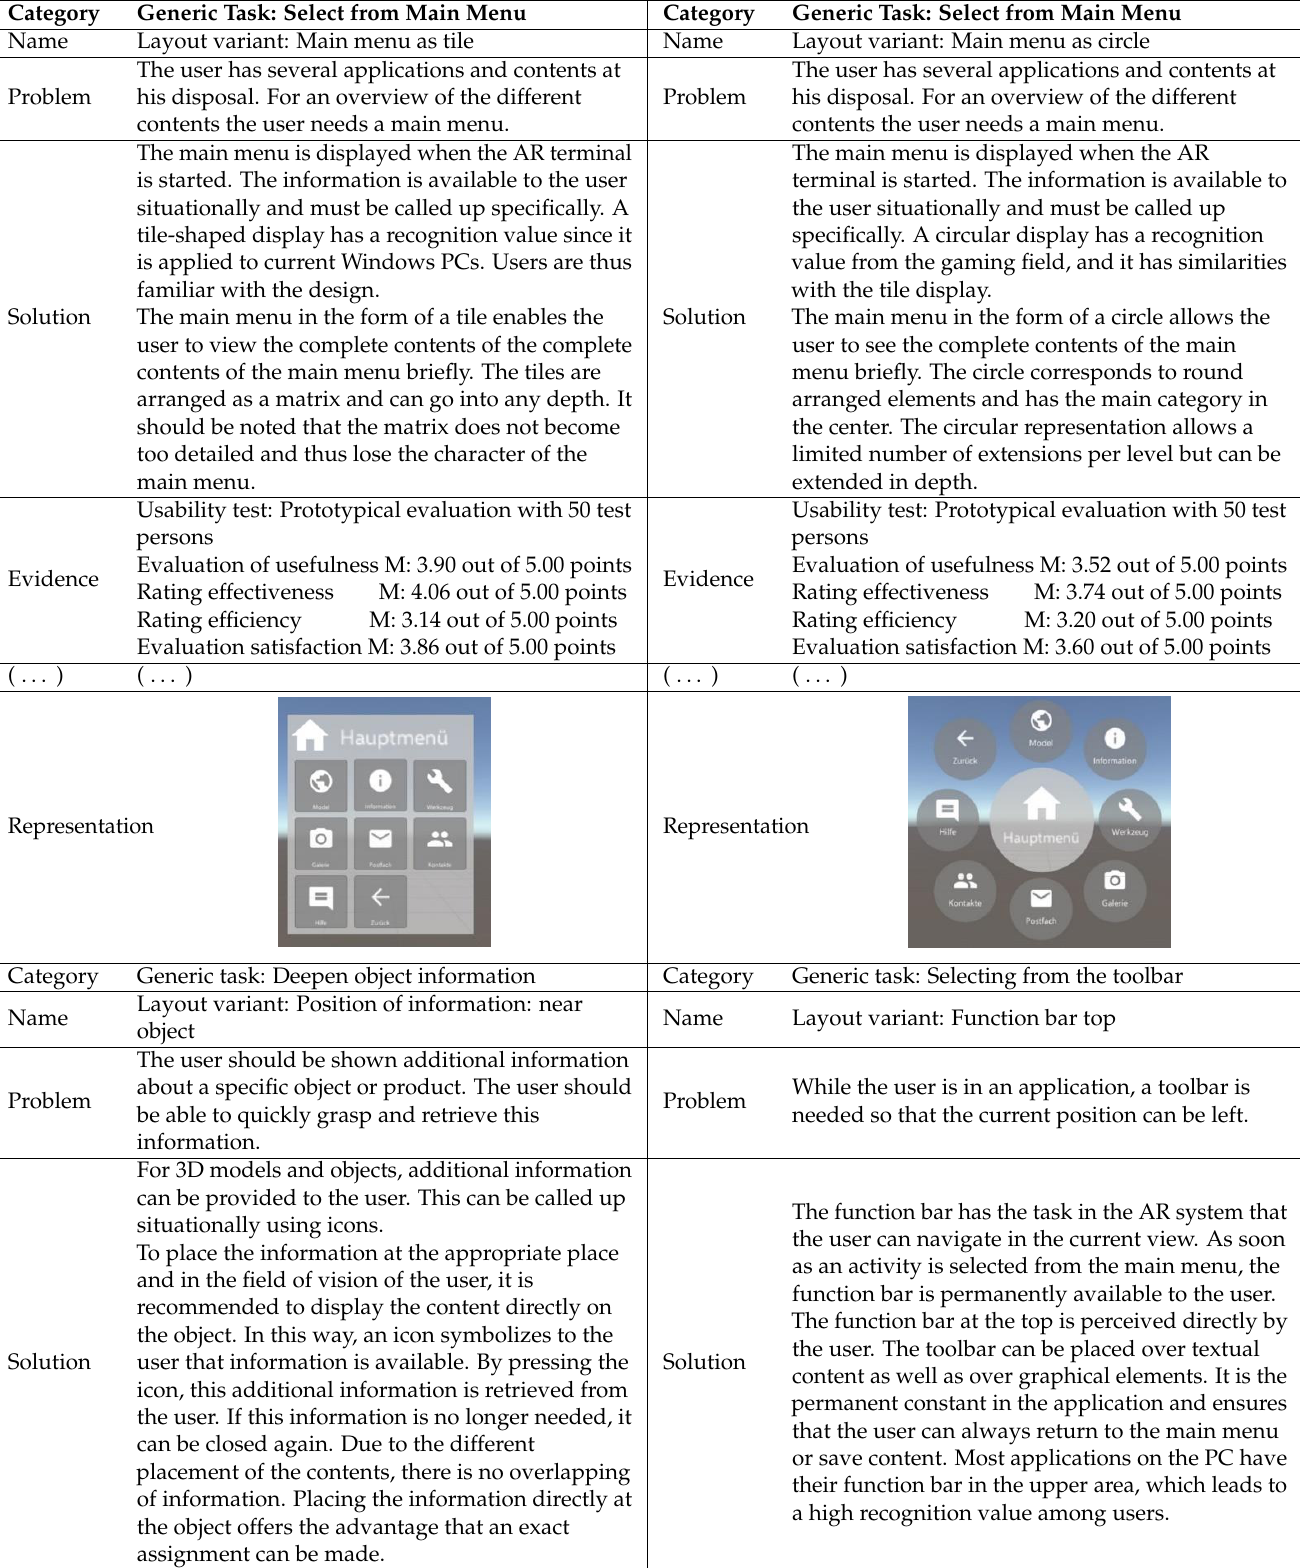
Table 12. Examples from the catalog with pattern. Part 1: Variants of the